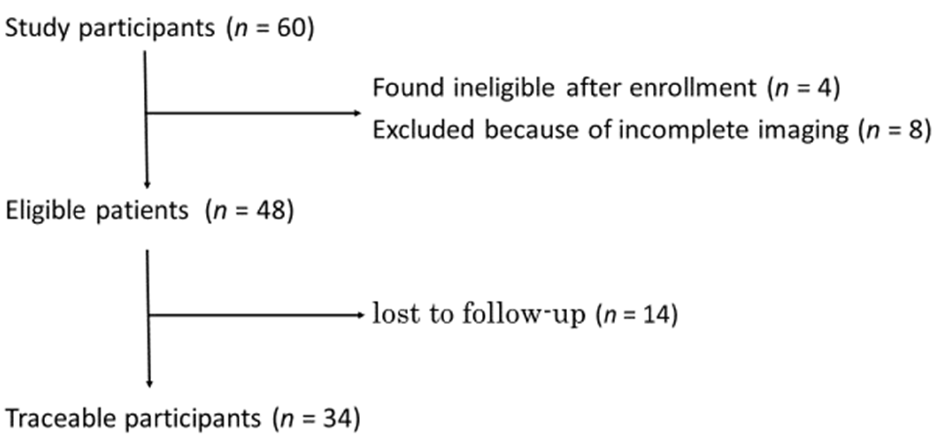
Figure 2. Flow chart of enrolment.